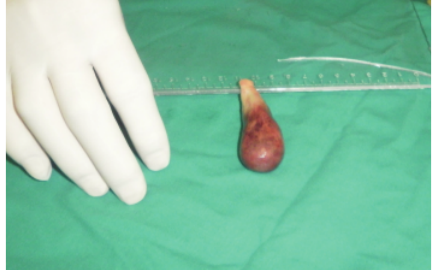
Figure 2: Fibroelastoma after surgical